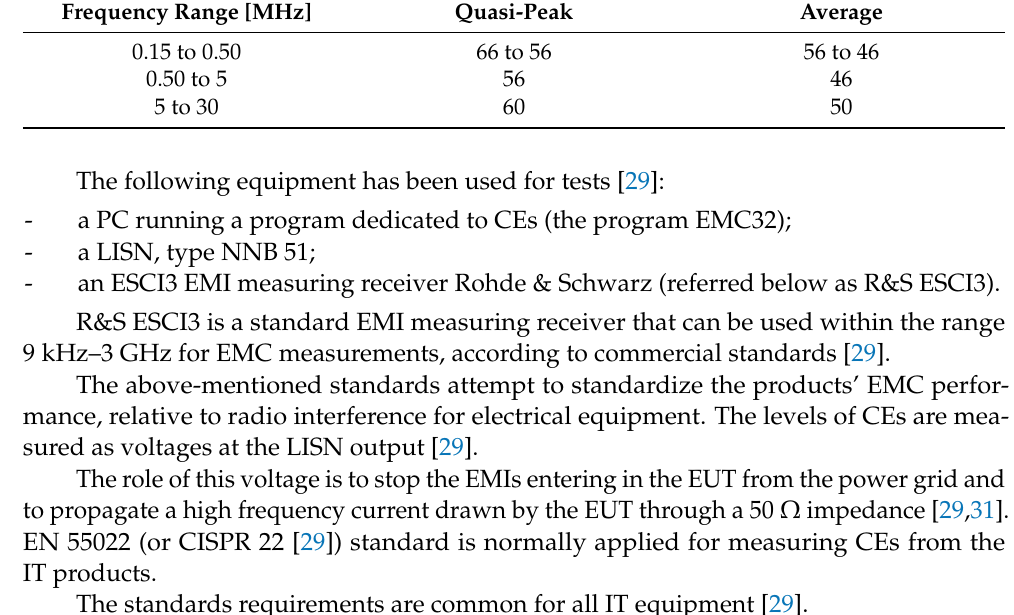
Table 4. Limits of disturbance voltages at the supply terminals for equipment in class B [29]. Limits [dB( µ V/m)] Frequency Range [MHz] Quasi-Peak Average 0.15 to